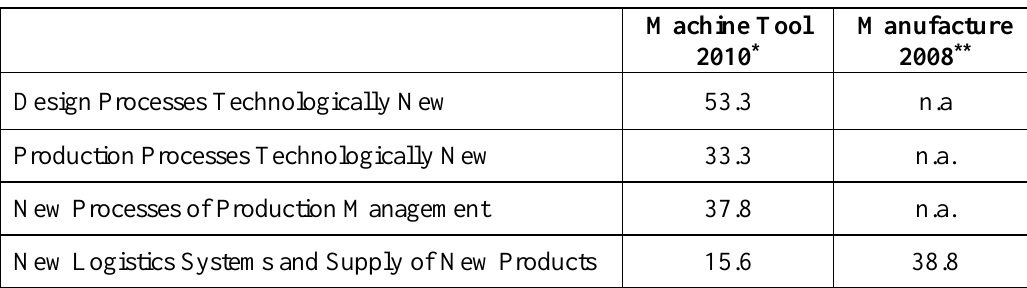
Table 3: Types of Process Innovations Introduced in the Last Three Years (% of Total Enterprises with Process